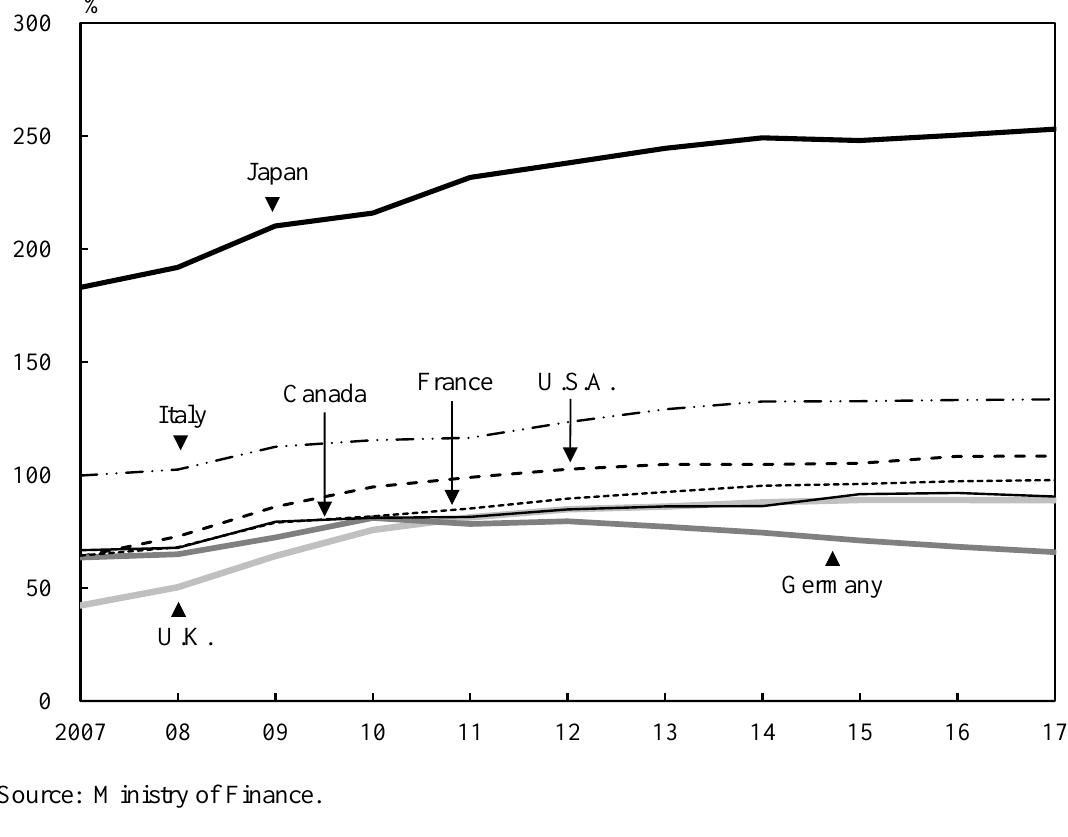
Figure 4.5 Ratio of General Government Gross Debt to GDP